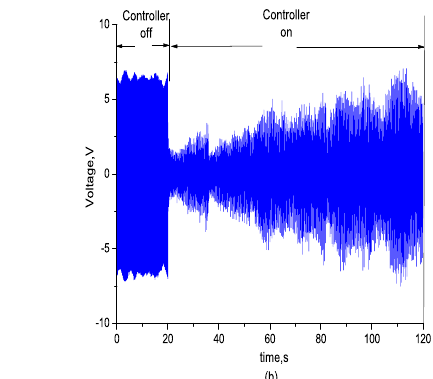
C = 12 nF; ( b ) self-sensing signal with no local strain p